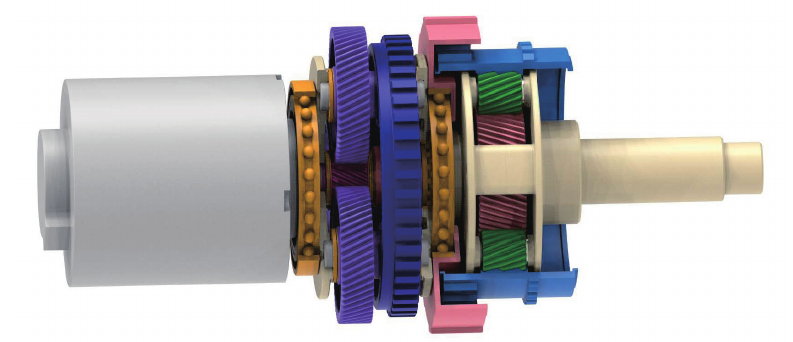
Figure 3. Structure of the planetary gear